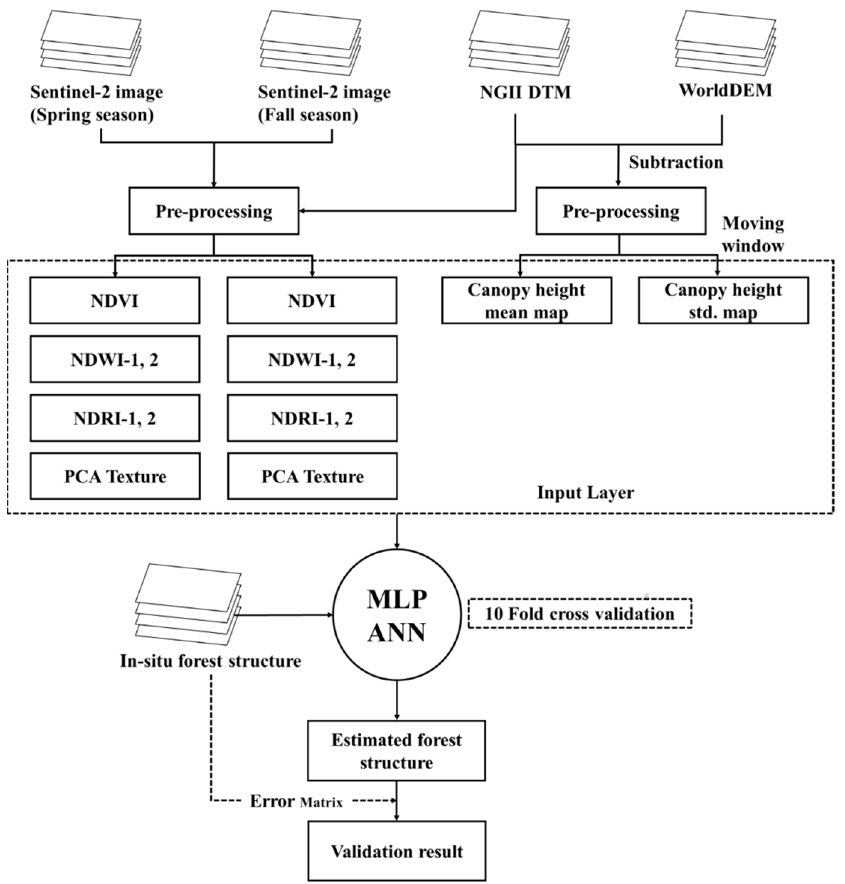
Figure 3. Overall data processing flow to map the forest vertical structure.